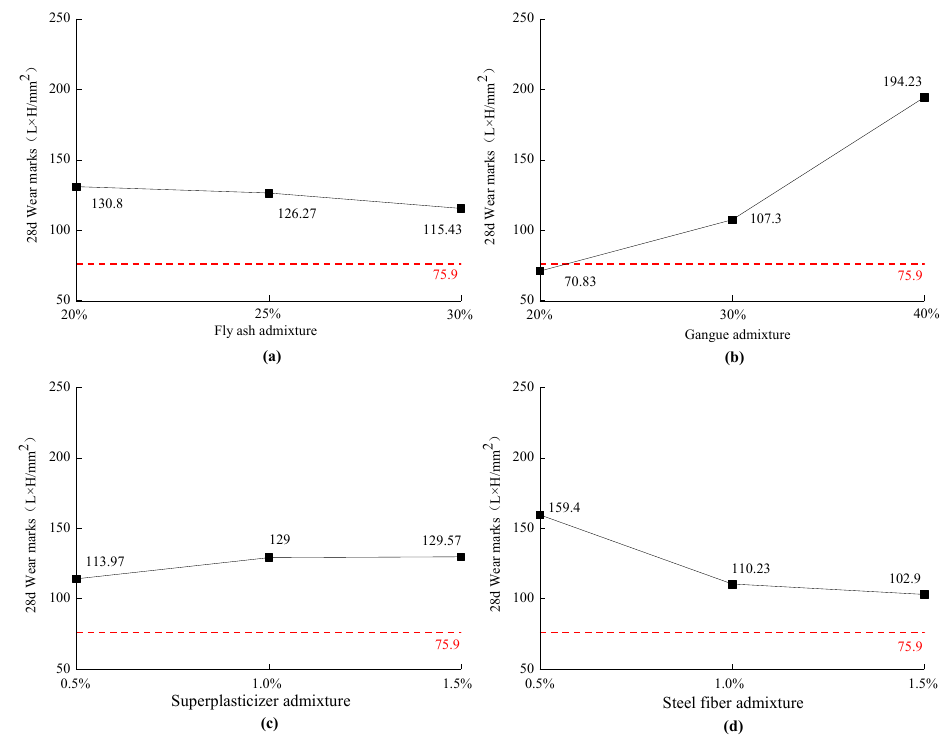
Figure 21. Influence of various factors on abrasion resistance of concrete. ( a ) The influence of fly ash on the wear resistance of concrete. ( b ) The influence of gangue on the wear resistance of concrete. ( c ) The influence of superplasticizer on the wear resistance of concrete. ( d ) The influence of steel fiber on the wear resistance of concrete.